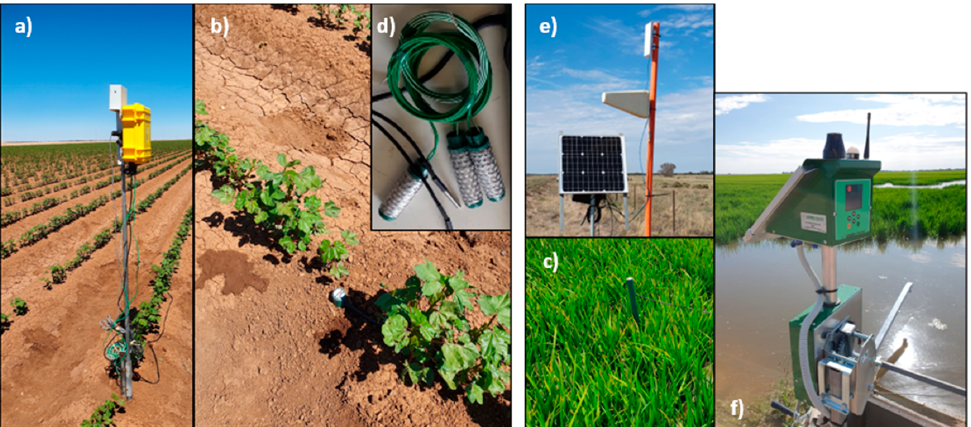
Figure 3. Pictures of a datalogger ( a ), multisensor capacitance probes installed in a cotton and rice farm ( b , c ), Watermark sensors ( d ), a Wi-Fi access point ( e ), and an IoT irrigation control autowinch ( f ). Table 2. Details of the farms and parameters monitored at each of